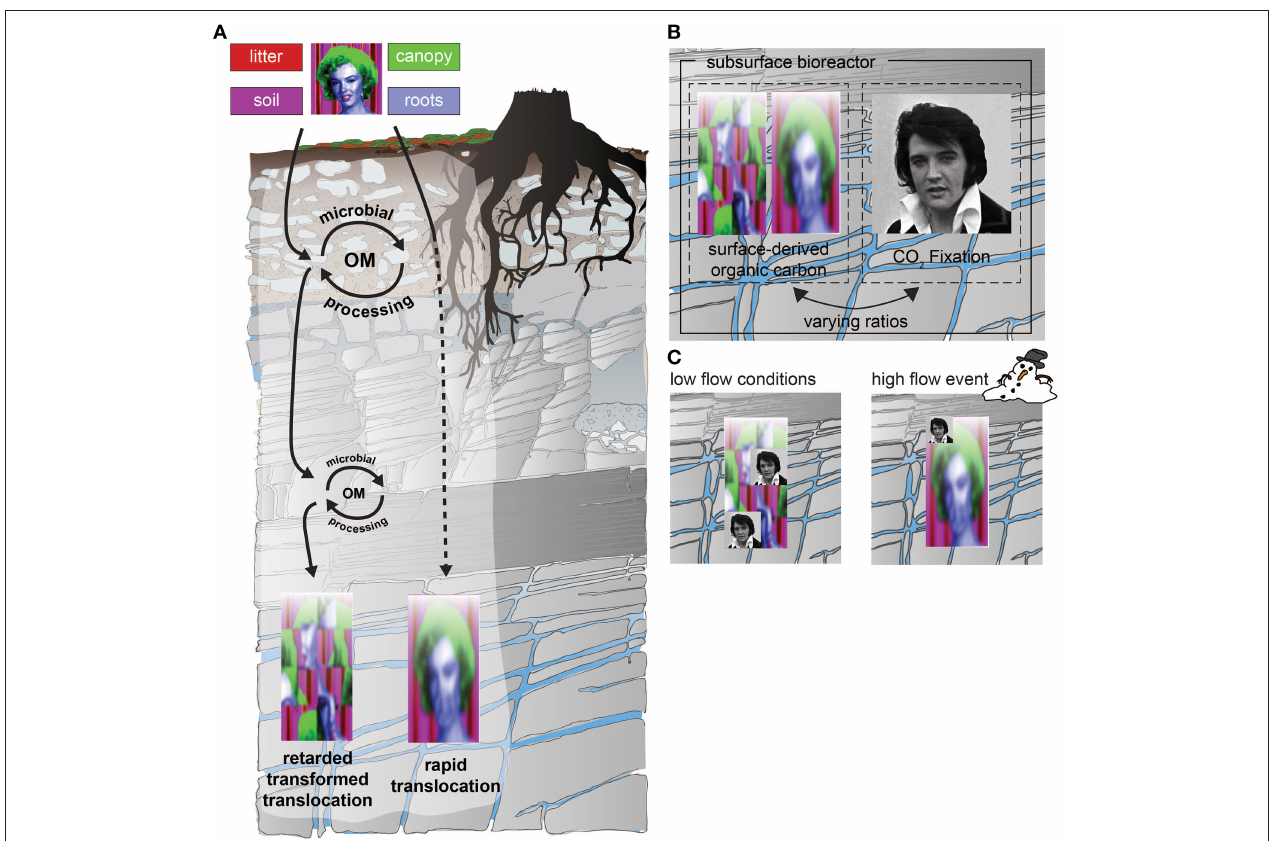
FIGURE 4 | (A) Potential transformations of signals (components of Marylin) originating at the surface and moving through the subsurface CZ. Signals include individual biomarker molecules or collections of compounds, colloids or even organisms specific to surface origin or indicative of surface processes. These are transported down through the CZ by water, but can be transformed by incorporation into subsurface biota or diluted by other signals. (B) The subsurface CZ is not just a zone through which materials move and are filtered/transformed, it is also the habitat for chemolithautotrophs (represented here by Elvis) that can add completely new signals, or patterns of nutrient/energy use. (C) The degree to which these signals travel in the subsurface CZ depends on the relative rates of input, but also on the flow (connection) between zones. For example, under low flow conditions ( ∼ 0.2 mm/day), where the subsurface CZ is more disconnected (left), the